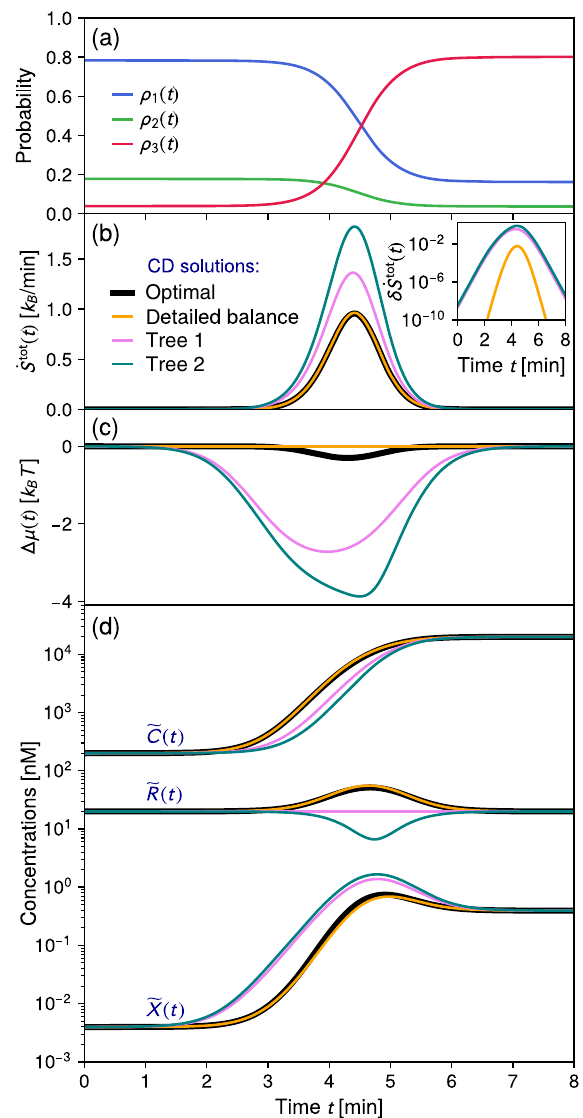
FIG. 6. (a) Components of the target stationary distribution trajectory ρ ð λ t Þ (solid curves) for the repressor-corepressor system. (b) – (d) Characteristics of four different control protocols that all drive the system along the target trajectory ρ ð λ t Þ . The four protocols are: spanning tree 1 (violet, corresponding to Fig. 5(b)); spanning tree 2 (teal, corresponding to Fig. 5(c)); the solution satisfying local detailed balance, Δ μ ð t Þ ¼ 0 at all t (yellow); and _ S tot the optimal solution that minimizes ð t Þ at all t (thick black). For each case we depict: (b) the total entropy production rate _ S tot _ S tot _ S tot ð t Þ , with the inset showing the difference δ ð t Þ ≡ ð t Þ − _ S tot ; opt ð t Þ between non-optimal and optimal rates on a log scale [units: k B /min]; (c) the instantaneous chemical potential Δ μ ð t Þ ; ˜ C ˜ R ˜ X (d) the concentrations ð t Þ , ð t Þ , ð t Þ